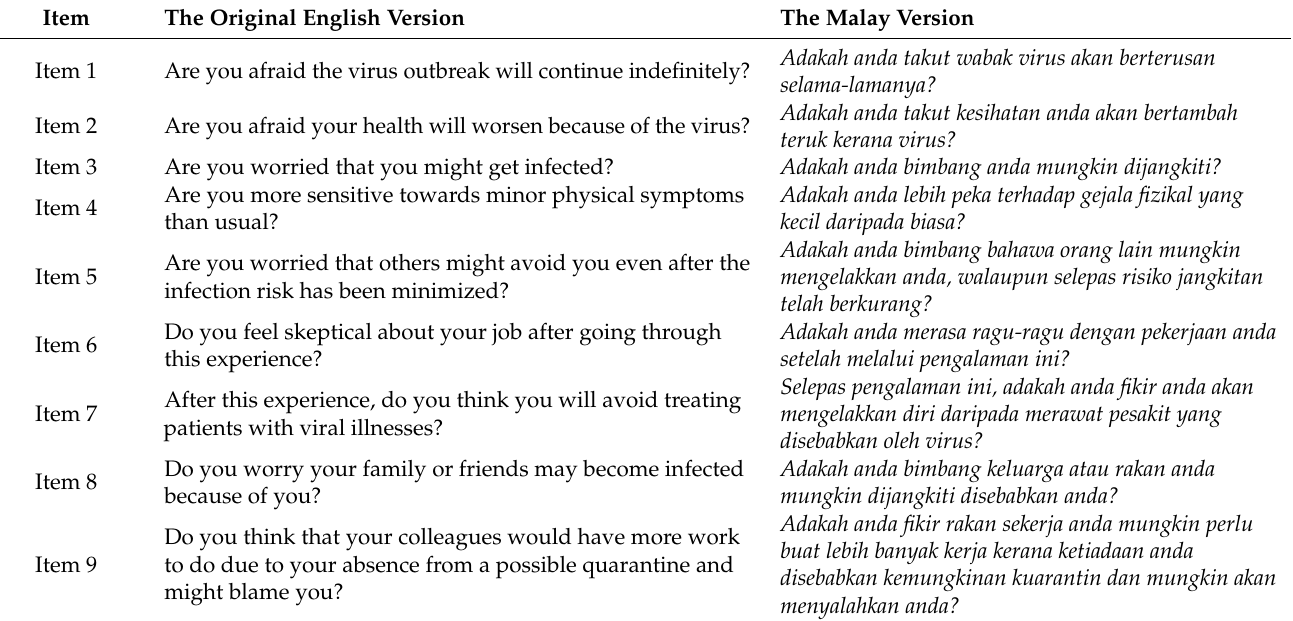
Table 1. The original English version and the Malay version of the SAVE-9.